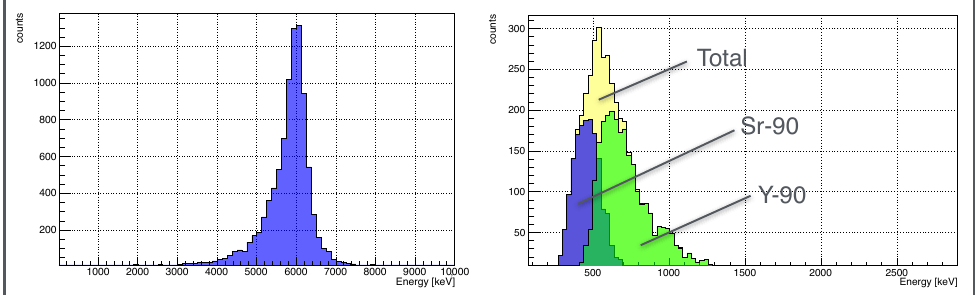
Figure 6. Left canvas: Am-241 α particles energy spectrum. Right canvas: Sr-90 β particles energy